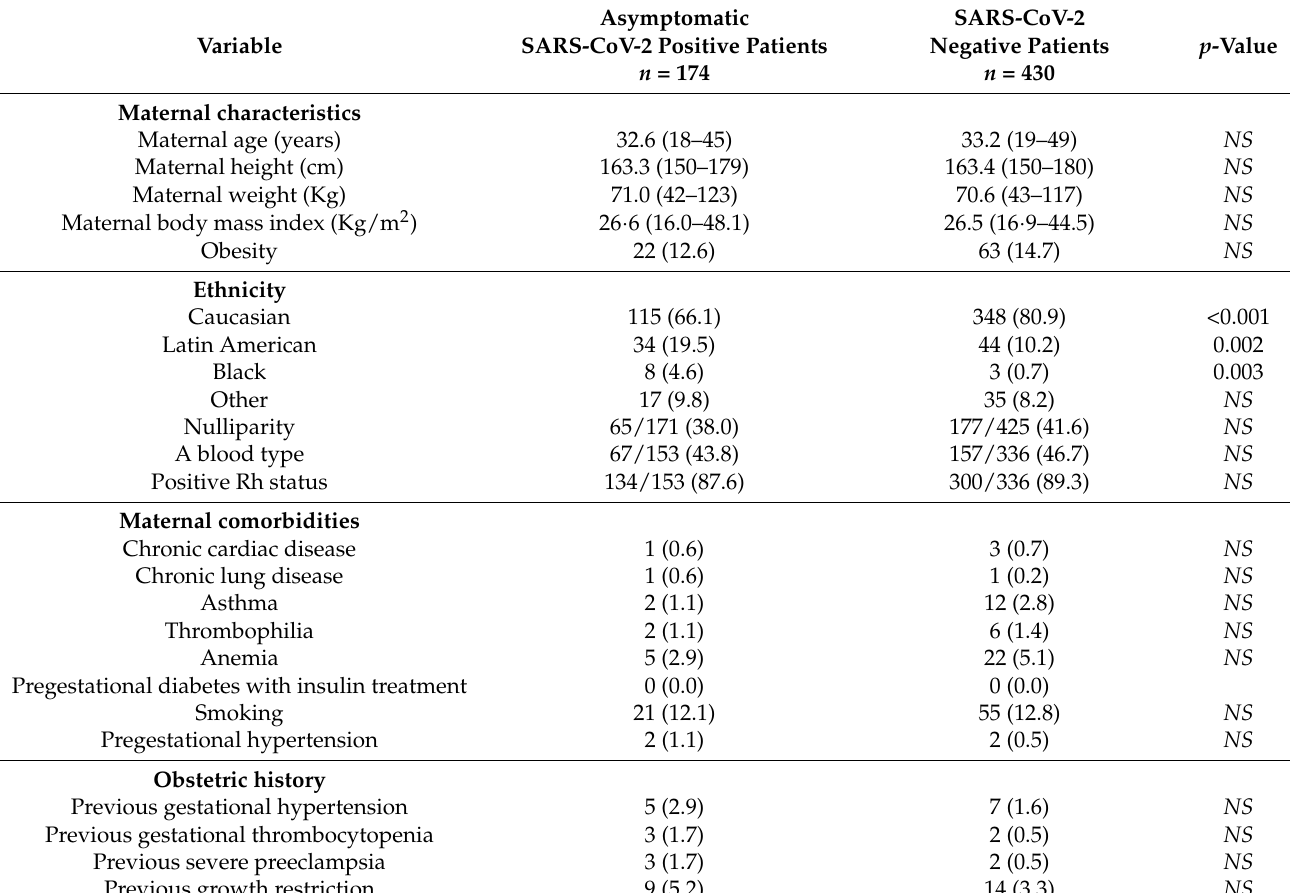
Table 1. Baseline characteristics of the study participants ( n =